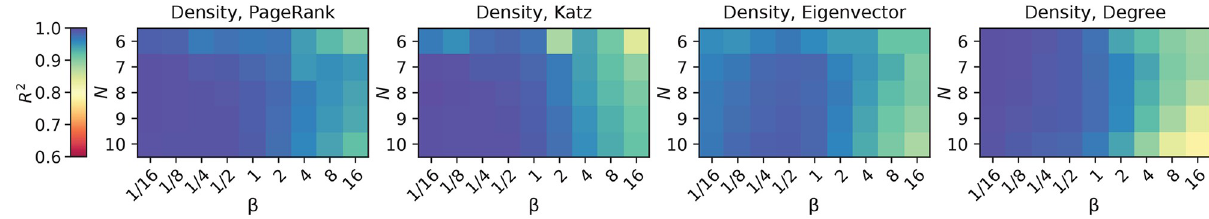
Fig 9. The predictability of one node metric and density (the number of edges in the graph of a node). The coefficient of determination R 2 when O ( β ) is estimated over graphs of N nodes similar to Fig 8. The panels show the top four centralities in terms of the minimum R 2 value over all parameter combinations: R 2 = 0.92 for both PageRank and Katz, 0.88 for eigenvector centrality and 0.78 for degree.